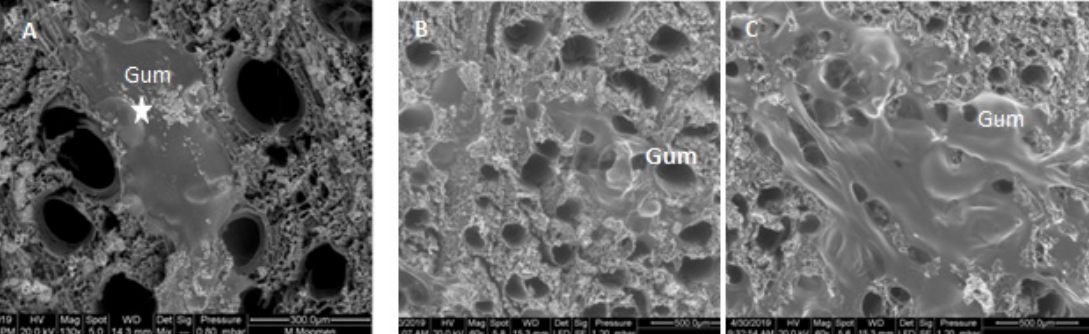
Figure 7. Scanning electron micrographs showing gum occlusions on xylem vessel surfaces. ( A ): entirely obstructed area in Sakasly vessel with gum (asterisks) ( B , C ): diffuse and condensed gum deposits on vessel lumens of Khamri and Hencha cultivars. Vessel elements enriched with starch grains were also detected in stem cross sections.